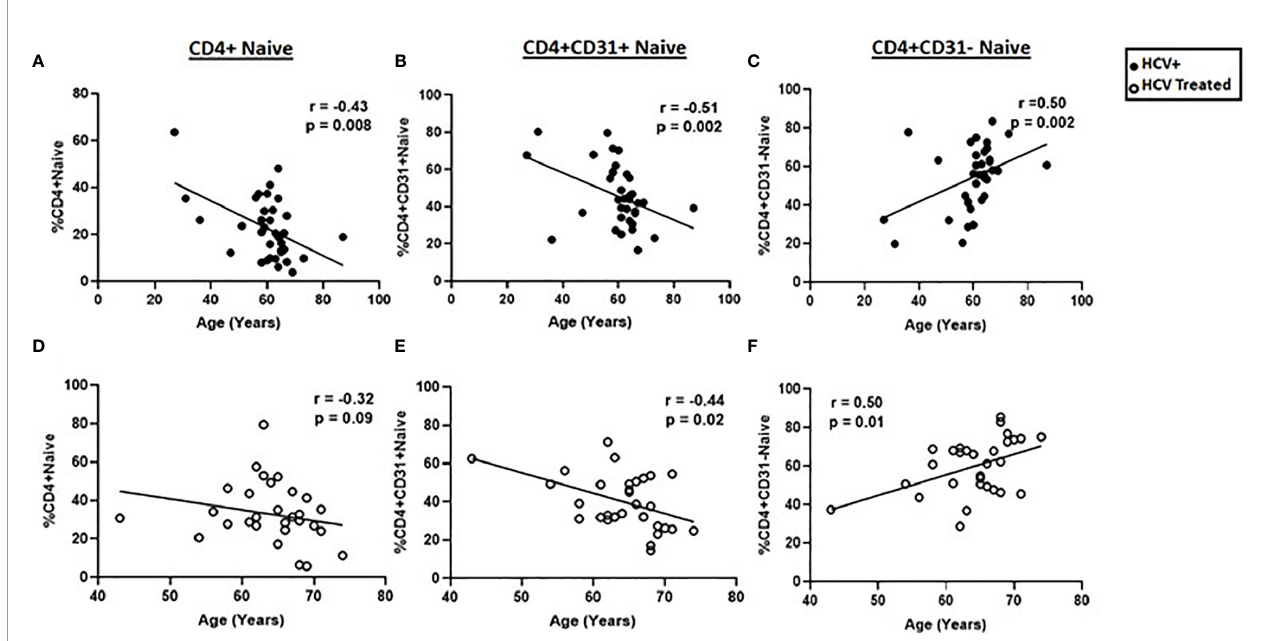
FIGURE 2 | Age negatively correlates with naïve CD4+ and CD4+CD31+ proportions and positively correlates with naïve CD4+CD31- proportions. The correlations between age and the naïve CD4+, (A, D) CD4+CD31+ (B, E) and CD4+CD31- (C, F) T cell proportions were determined in chronic HCV infected ( fi lled circles, n=34) and HCV DAA-treated (open circles, n=29) individuals. Spearman ’ s rank sum test was used; p= <0.05 considered signi fi